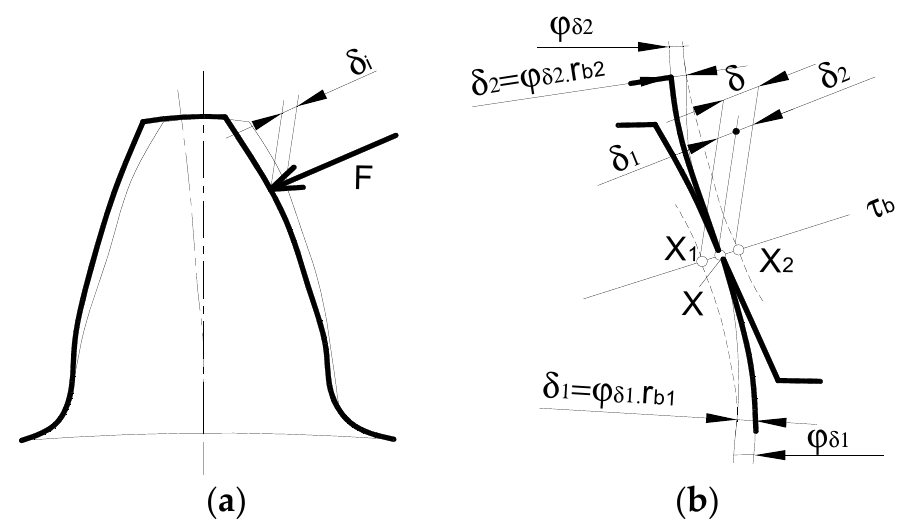
Figure 2. Deformation of ( a ) tooth, ( b ) teeth meshing deformation. However, in reality, it is necessary to determine the deformation of the interlocking teeth, i.e., the deformation of a pair of teeth, which can be imagined and illustrated in Figure 2b. This figure shows a section of a pair of teeth, which touch at the point X on a line of action τ b in the unloaded state. After loading, the profiles of the two teeth engaging together deformed into the shape shown by the dashed line in the respective figure. These already deformed tooth profiles intersected the line of action at points X 1 and X 2 . The total deformation of this pair of teeth δ could then be determined as the sum of the defor- mations of both teeth δ 1 and δ 2 . There are the angles φ δ 1 and φ δ 2 shown in figure 2. These